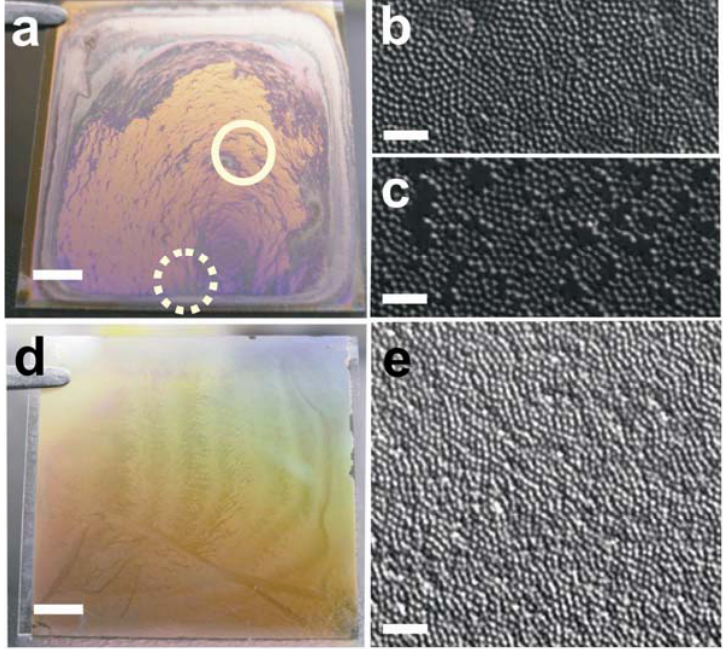
Figure 2. Photographs and differential interference microscopy (DIC) images of films fabricated using ( a ) the drying method and corresponding DIC images of an area that is an ( b ) etalon corresponding to the solid circle in (a) and an area that ( c ) is not an etalon corresponding to the dashed circle in (a). ( d ) A photograph of a film fabricated using the “paint-on” method and the corresponding ( e ) DIC image of the film. DIC images were taken using a 100x oil immersion objective before the addition of Cr/Au overlayer, scale bars are 5 µm. Scale bars in the photographs are 5 mm. Reprinted with permission from [13] Copyright (2011) American Chemical